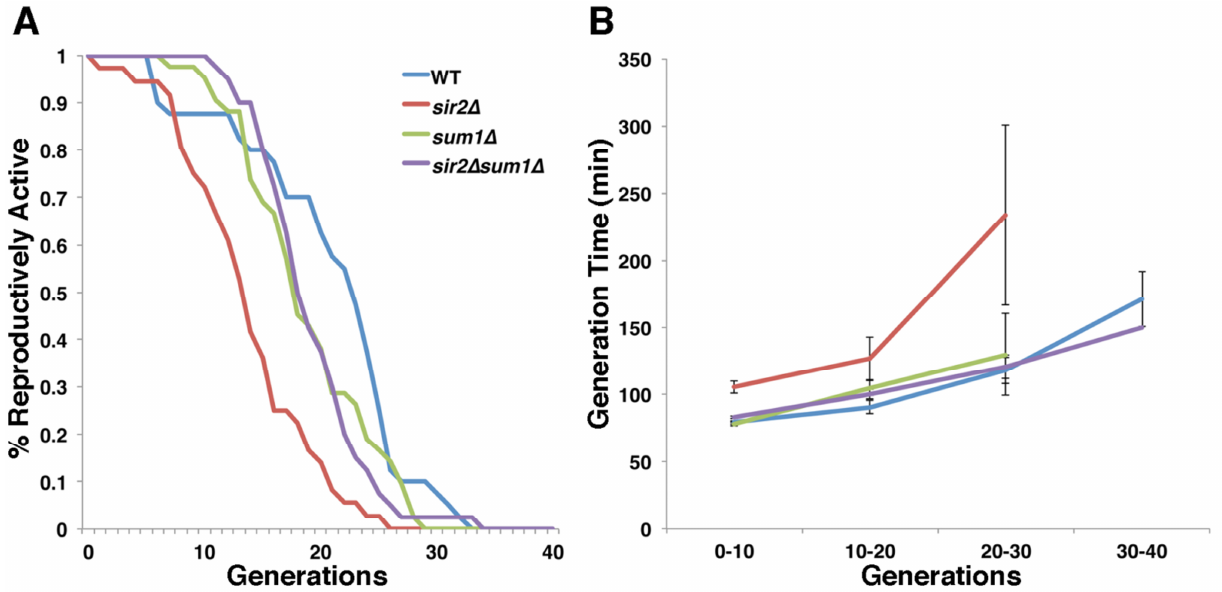
FIGURE 5: Deletion of SUM1 rescues defects in RLS and cellular health span of sir2 ∆ cells. (A) RLSs of wild-type, sir2 ∆, sum1 ∆, and sir2 ∆ sum1 ∆ cells were determined as described in Materials and Methods. (B) Mean generation time was determined during the RLS assay as described in Materials and Methods. Error bars represent SEM. n = 40 cells per strain. Data is representative of 2 independent